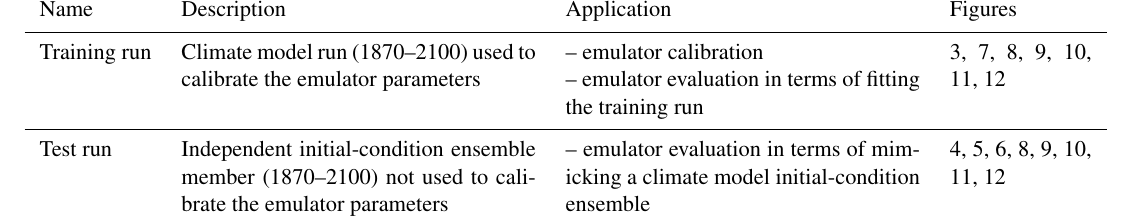
Table 1. Terms used to refer to different climate model runs throughout this study.